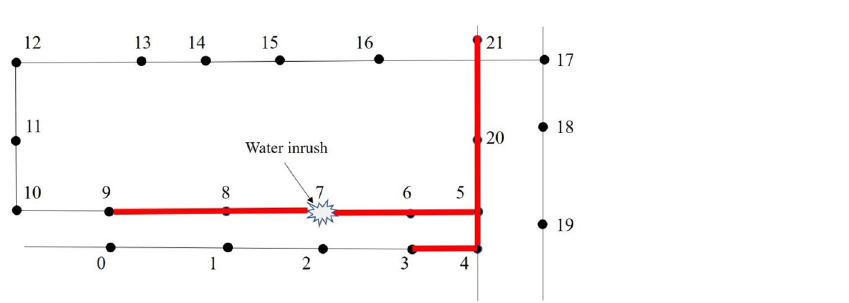
Figure 1. Construction of topological structure of coal mine tunnels.